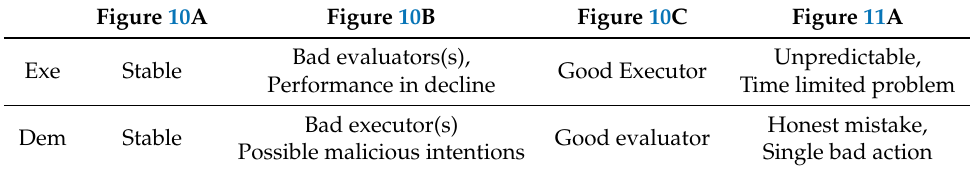
Table 1. Possible interpretations of the identified reputation trends. Exe, executor; Dem, demander. Figure 10A Figure 10B Figure 10C Figure 11A Bad evaluators(s), Unpredictable, Exe Stable Good Executor Performance in decline Time limited problem Honest mistake, Single bad